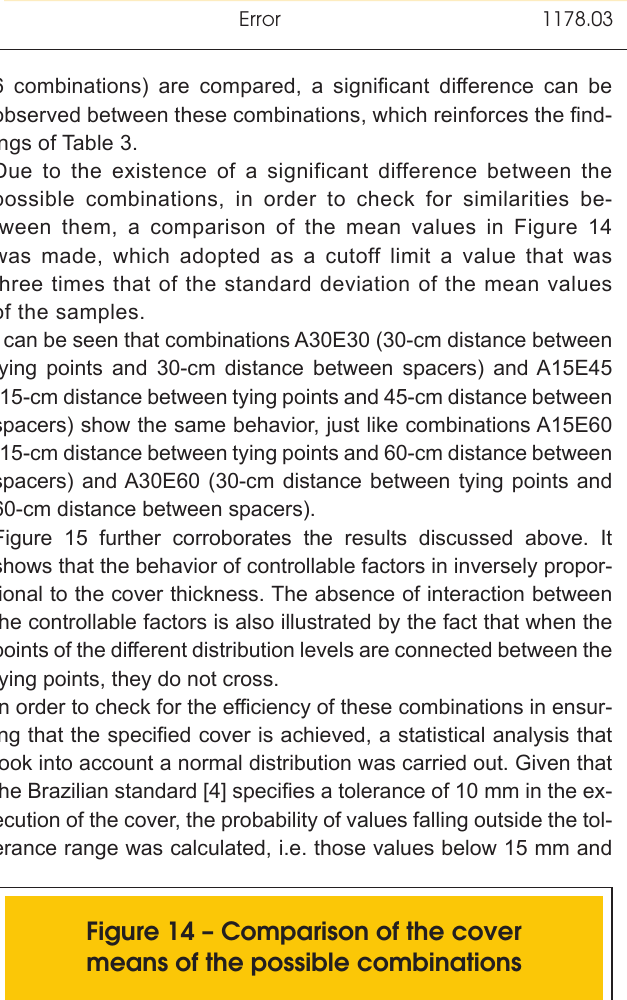
Figure 14 – Comparison of the cover means of the possible combinations